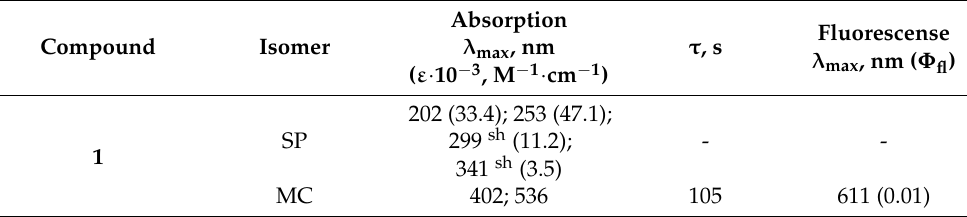
Table 1. Spectral and kinetic properties of spiropyran 1 in acetonitrile, T = 293 K. Compound